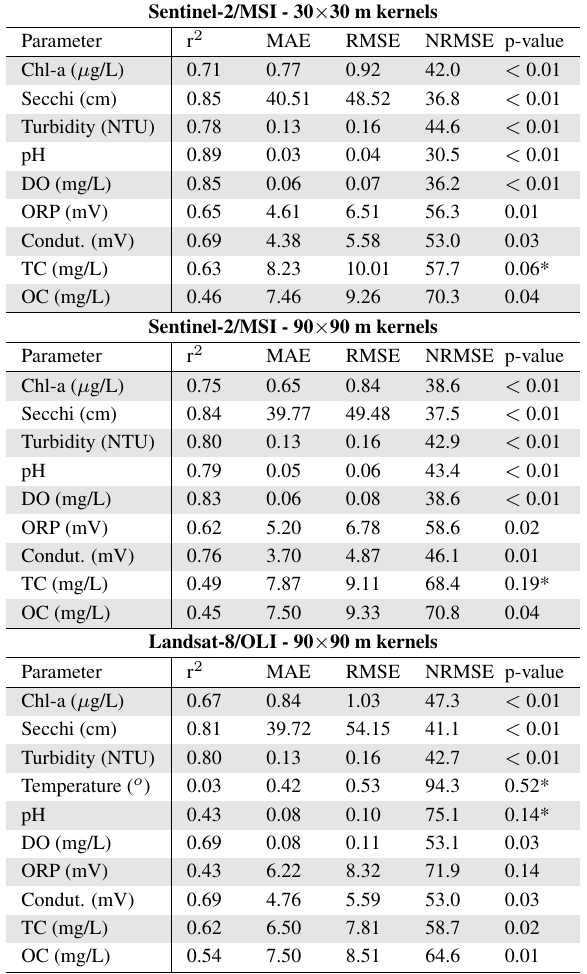
* models not considered valid using the p < 0 . 05 critical value. Table 6. Evaluation metrics for all models and for the three image situations considered (MSI-30, MSI-90 and OLI-90) of water is related with the concentration of ions, specifically dissolved salts from inorganic material. These chemical ana- lysis were not available for this article but TC concentrations